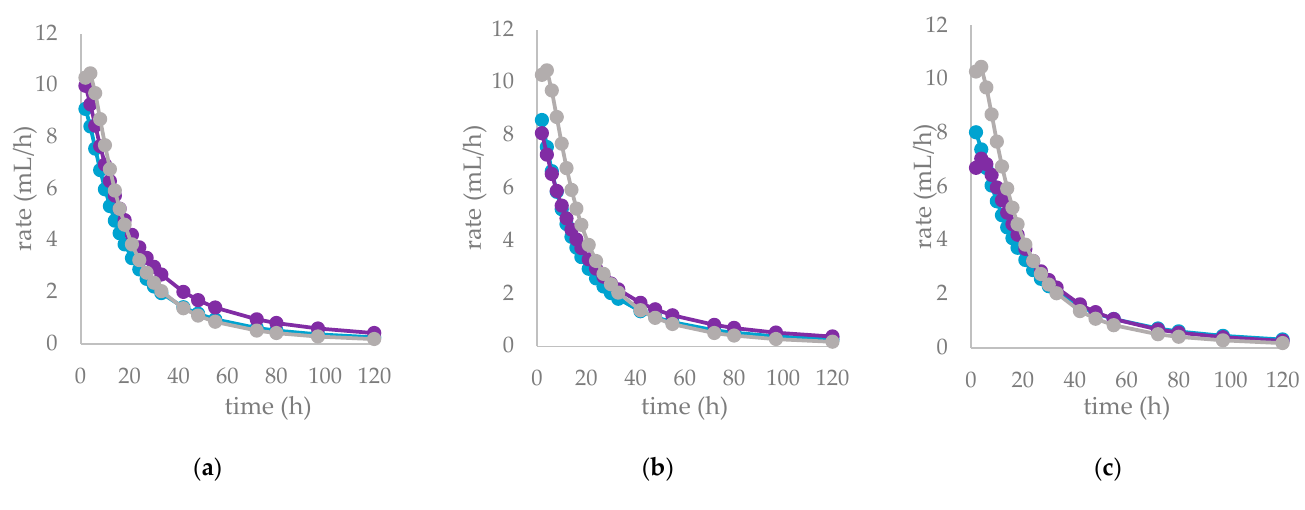
Figure 6. In vitro fermentation rate over time of C. sativa Cs/1/1 extract ( A ) and its fractions Cs/2/1 ( B ) and Cs/3/2 ( C ) at the 50-mg ( ● ) and 200-mg ( ● ) dose levels and control diet ( ● ). Table 6. In vitro gas production and fermentation rate of different C. sativa extracts after 24 h of incubation. OMD: organic matter degradability; CH 4 (mL/g iOM): methane production related to incubate organic matter; CH 4 (mL/d OM): mL of methane production related to degraded OM. Along the row ** p < 0.01 and *** p < 0.001; NS : not significant; MSE: mean square error.